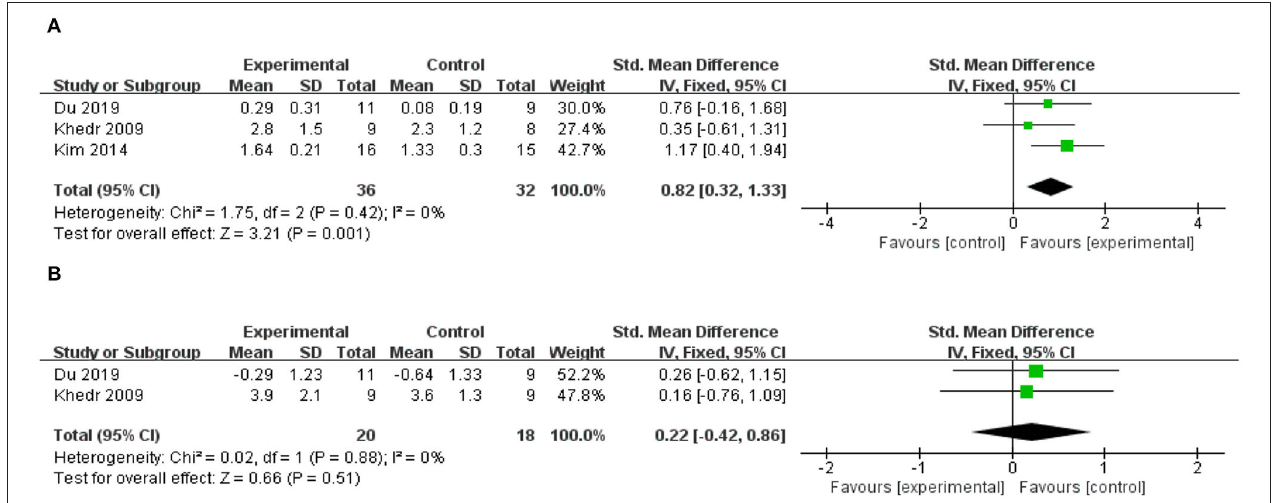
FIGURE 6 | (A) Forest plot from the meta-analysis of excitatory rTMS on MEP amplitude in the affected hemisphere showing estimates of effect size (SMD) with 95% confidence intervals. (B) Forest plot from the meta-analysis of excitatory rTMS on MEP amplitude in the unaffected hemisphere showing estimates of effect size (SMD) with 95% confidence